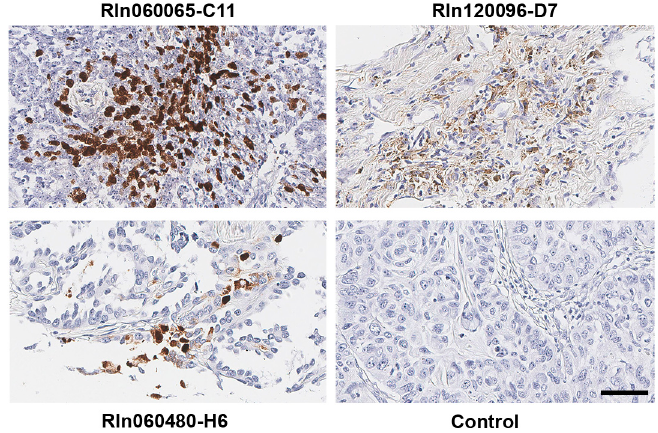
Figure 1. Detection of EBV marker small RNA EBERs in lung cancer cells. Images of para ffi n-embedded human lung cancer probed for EBERs using in situ hybridization. EBERs (brown signal) were detected in three non-small cell lung cancer cases. Patient IDs were shown above or below each image. Control (patient ID# Rln060040-B11) represents an EBV-negative lung squamous cell carcinoma case. Scale bar: 50 µ